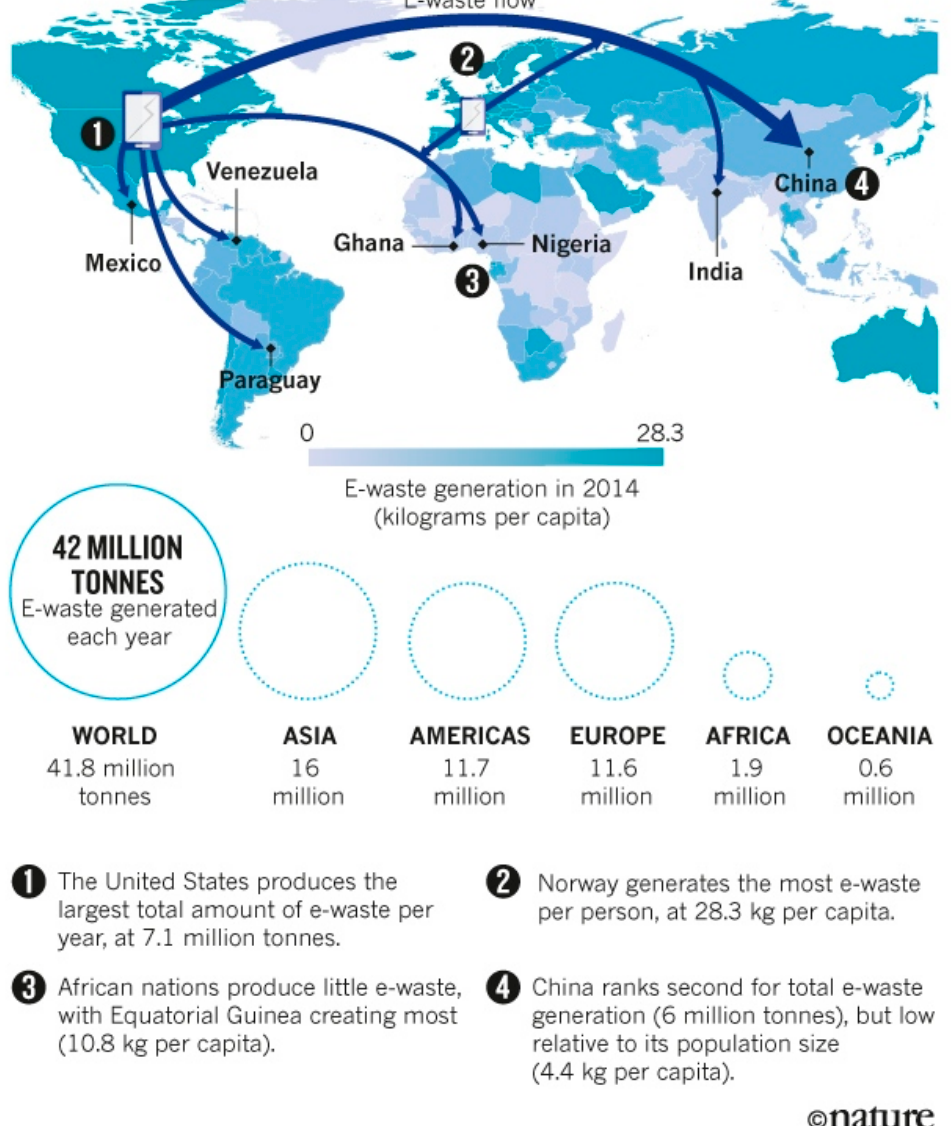
Figure 1. Transboundary movement of waste electrical and electronic equipment (WEEE) [9].